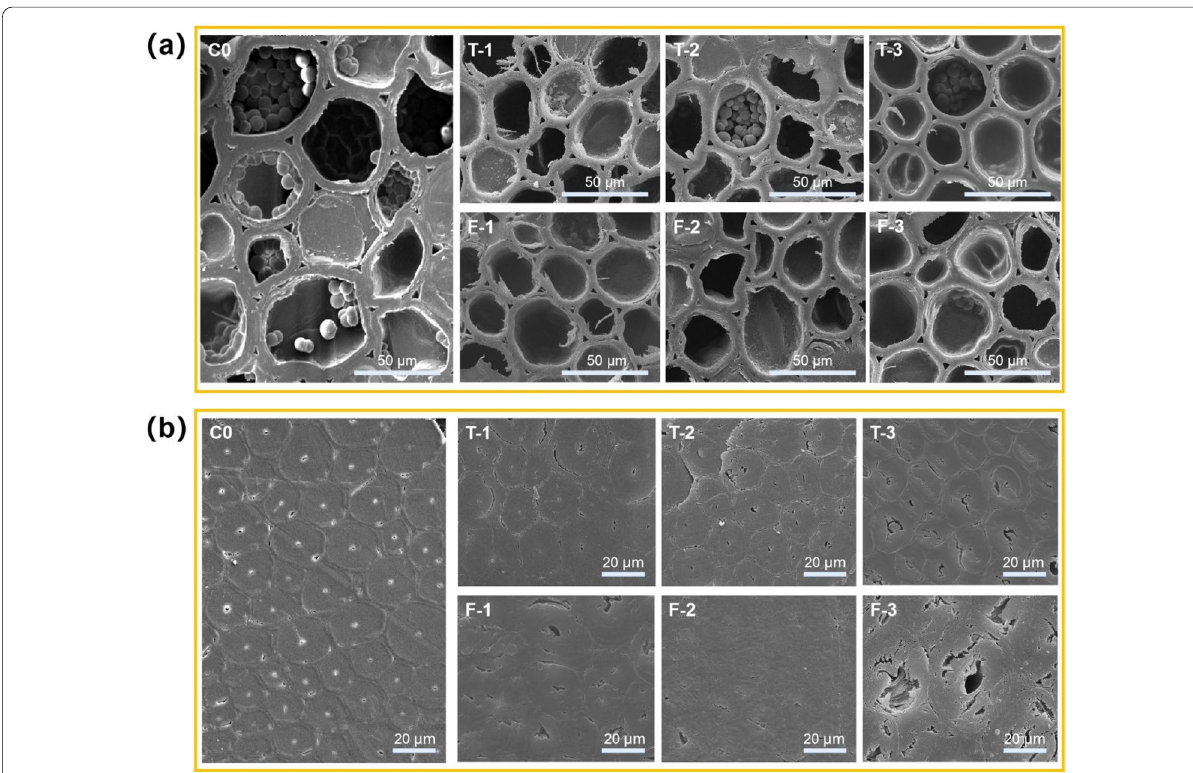
Fig. 2 Microstructure of freeze–thaw-treated a parenchyma cells and b fibers of inner layer bamboo